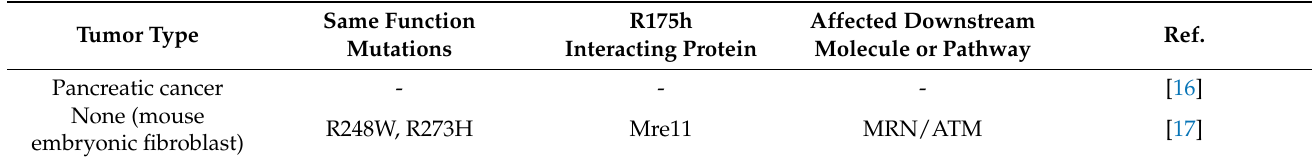
Table 2. Summary of p53-R175H gain-of-function of inducing genetic